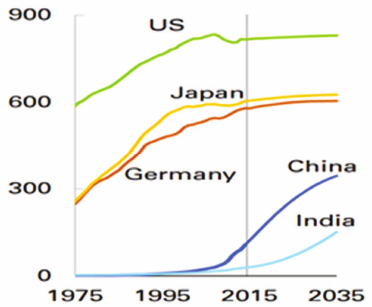
Fig. 1. Number of vehicles per 1 000 inhabitants in individual regions of the world